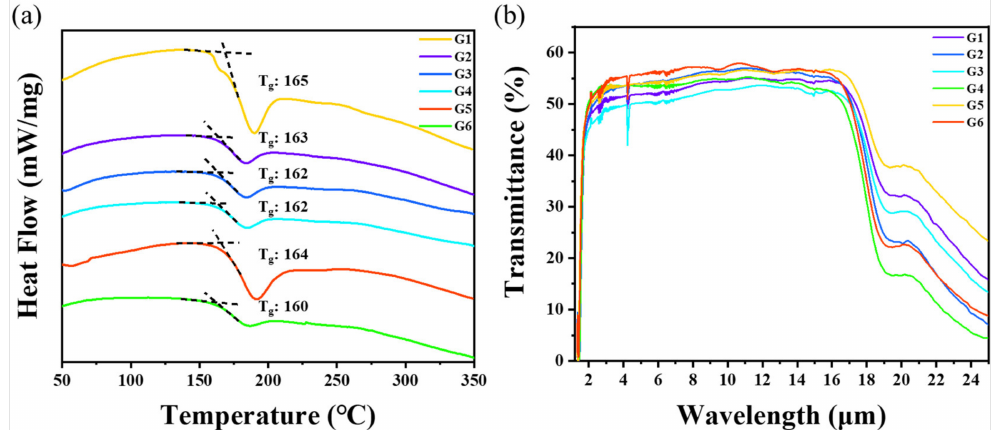
Figure 2. ( a ) DSC curves of the substrate glass at 10 K/min heating rate. ( b ) Infrared transmission spectra of the substrate bulk glass (1 mm thickness) at 1–25 µ m.